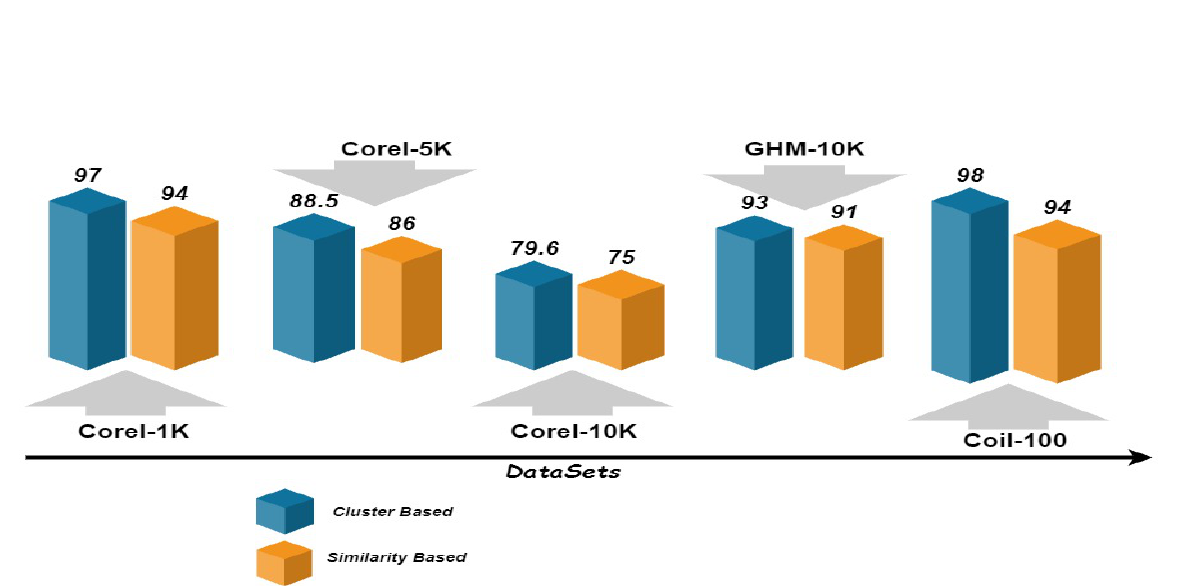
Figure 6. Comparison of average precision of both systems